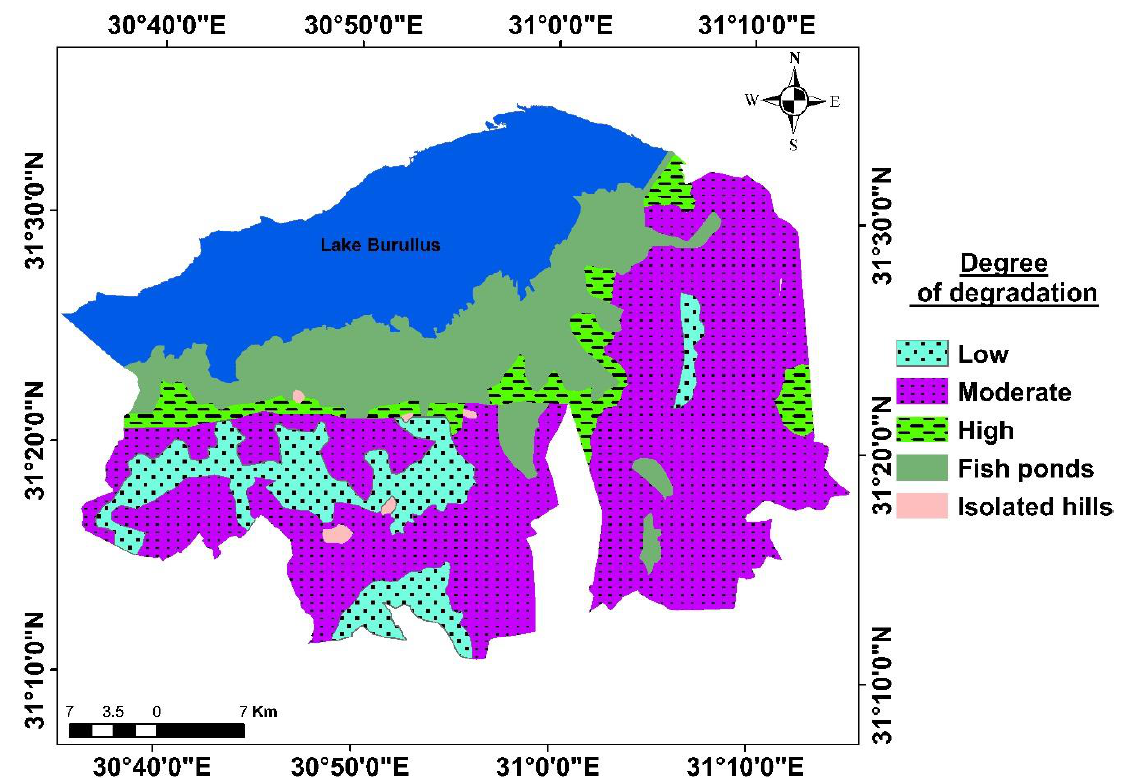
Figure 4. Soil degradation degrees of the studied